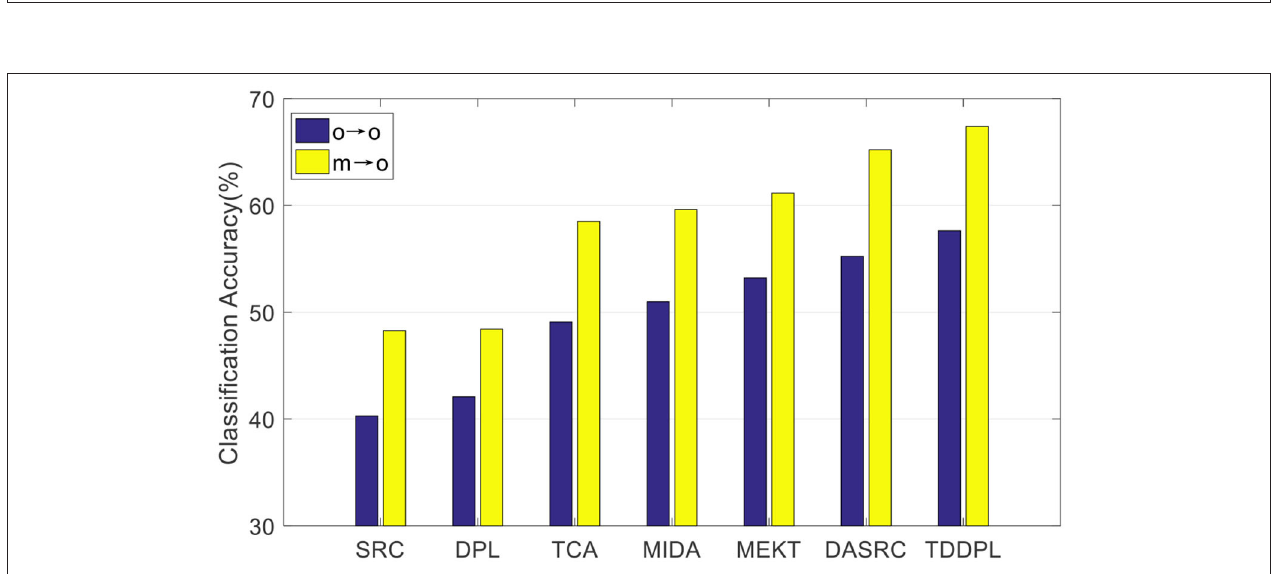
FIGURE 3 | Average classification accuracies on session 2 of the SEED IV dataset.